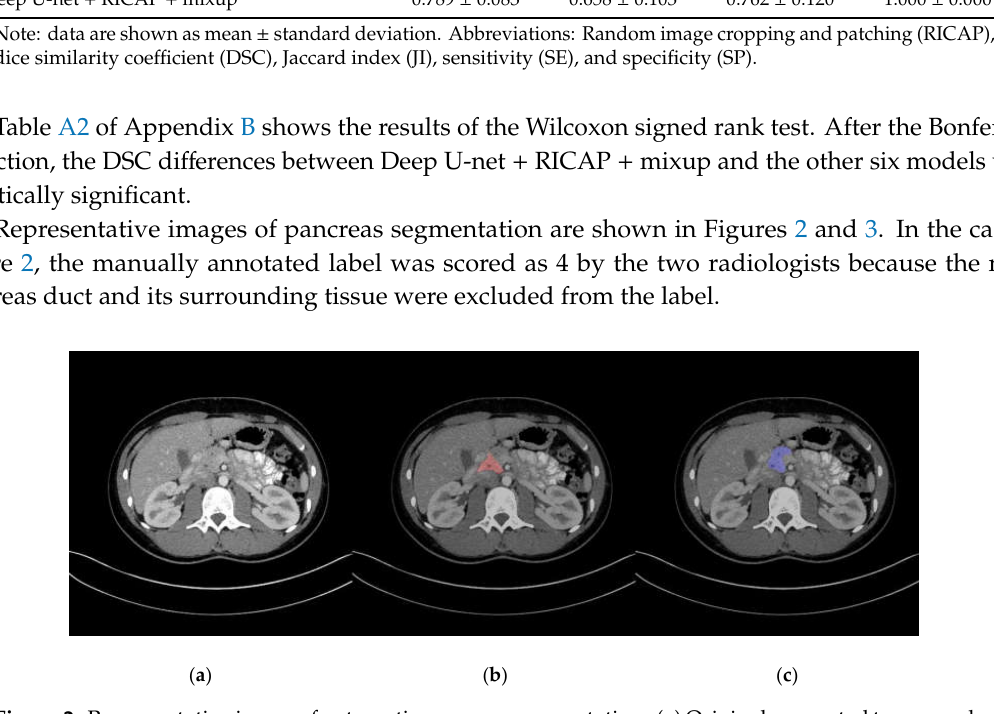
Figure 2. Representative image of automatic pancreas segmentation. ( a ) Original computed tomography (CT) image; ( b ) CT image with manually annotated label in red, scored as not perfect by two radiologists; ( c ) CT image with automatic segmentation in blue.